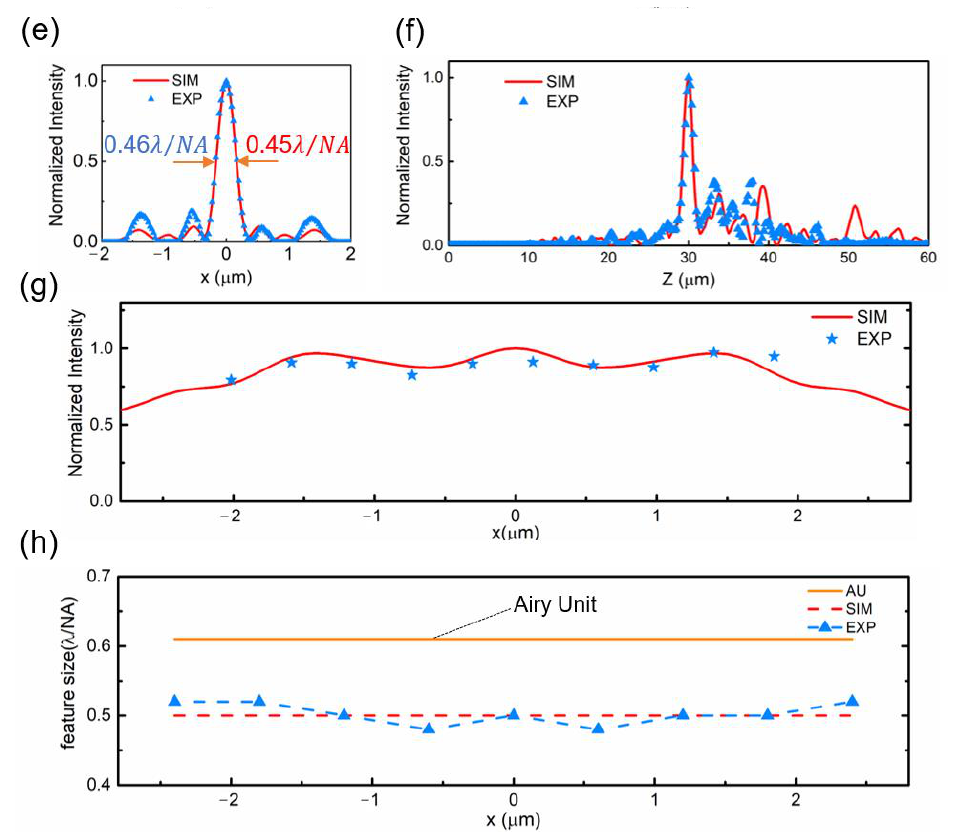
Figure 4. Light field distribution of the modified elliptical SCL. ( a , b ) Simulated result of the transverse optical needle in the XOY plane ( a ) and the XOZ plane ( b ) shaped by the modified elliptical SCL; ( c , d ) experimental result of the transverse optical needle in the XOY plane ( c ) and the XOZ plane ( d ); ( e ) intensity profiles of the transverse optical needle in the perpendicular direction, which is marked by the white dashed line in Figure 4a,c; ( f ) axial intensity distribution from the simulation (red line) and the experiment (blue dash symbol), which is marked by the white dash lines in Figure 4b,d; ( g ) intensity profiles along the transverse optical needle from the simulation (red line) and experimental results (blue star symbol); ( h ) the lateral sizes in a horizontal direction, which show a uniform sub-diffraction-limited optical needle.